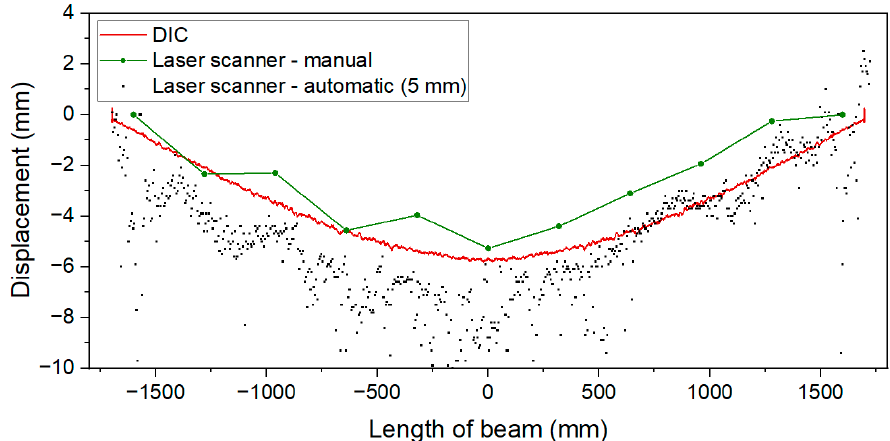
Figure 17. Comparison of deflection lines obtained with different methods.